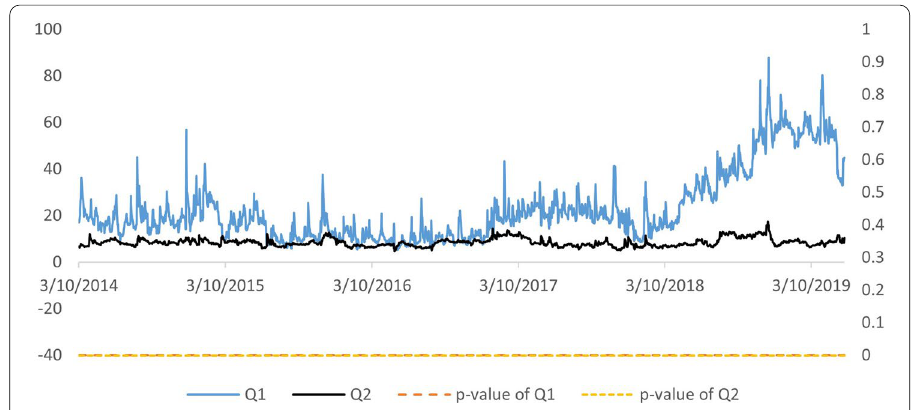
Fig. 6 Time-varying Granger test between GSVI and Trading Volume (Q1: trading volume-> GSVI; Q2: GSVI- > trading volume)